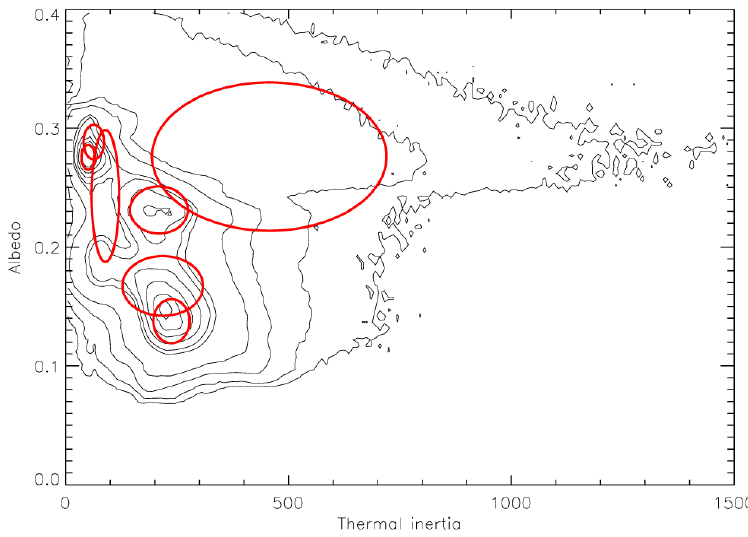
Figure 4. Assignment of Gaussians in the seven Gaussian Mixture Model. The ellipses represent the 1 standard deviation boundary from the mean in albedo and thermal inertia. Binsize for contours is 10.0 in thermal inertia and 0.005 in albedo. Contours are placed at counts: 40, 2 × 10 2 , 1 × 10 3 , 3 × 10 3 , 1.5 × 10 4 , 2 × 10 4 , 3 × 10 4 , 4.2 × 10 4 , 5.5 × 10 4 , 6.5 × 10 4